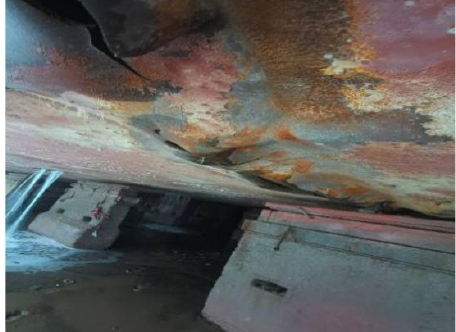
Figure 5. Tear and damage of the bottom outer plate.